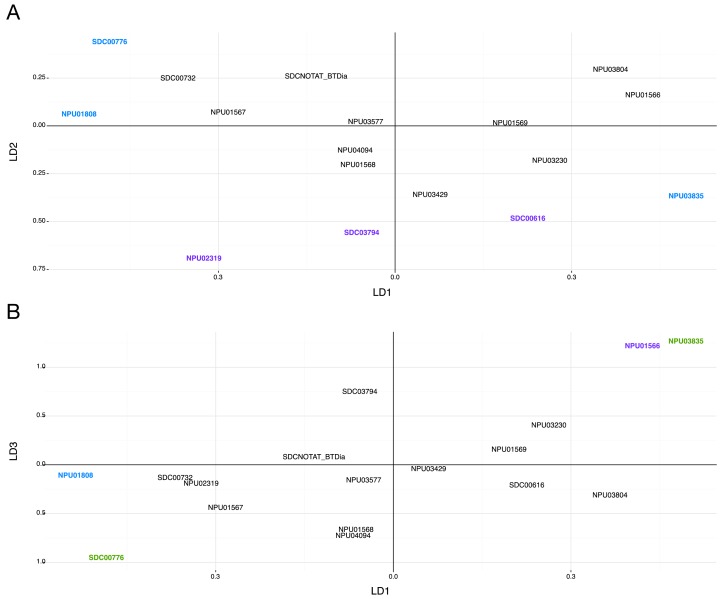
Linear Discriminant Analysis 2 (LDA).The three identifiers contributing most to the variance in the LDA (NPU04998, NPU18004, and SDCNOTAT_BTSys) were removed, and a new LDA analysis was performed. A and B display the relationship between LD 1, 2, and 3. Blue colored identifiers contribute the most to the variance between clusters for LD1, purple colored contribute the most to the variance for LD2 and 3, and green colored identifiers are the ones common among LD1 and 2, or LD2 and LD3.